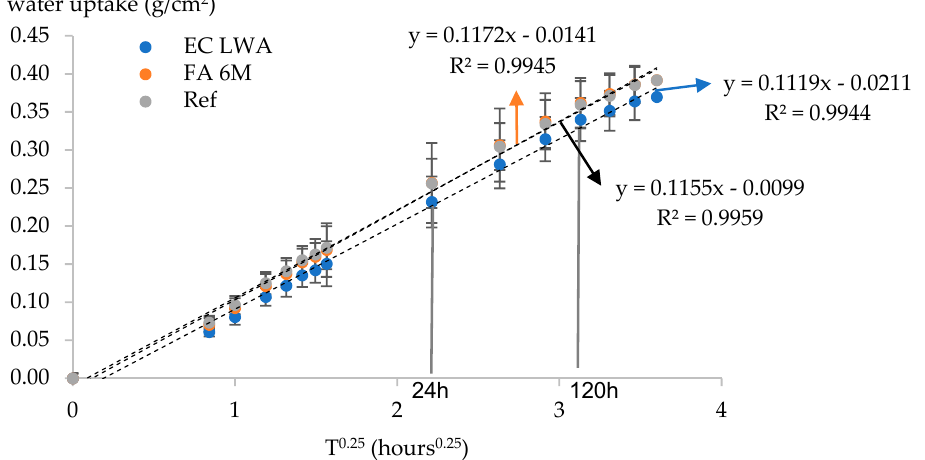
Figure 8. Capillary water uptake of the studied mortar plotted as a function of the fourth root of time. The dashed line refers to linear regression of each series.